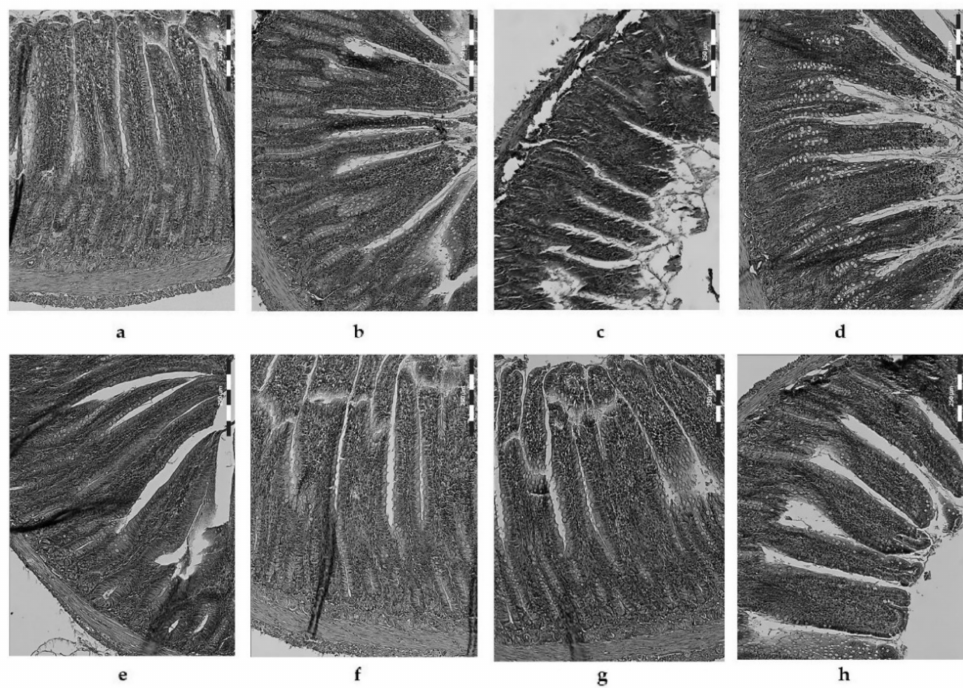
Figure 3. Histological examination of the rats’ ileum fed with control (C— a ), atherogenic diet (CH— b ) and CH diet supplemented with freeze-dried fresh (CHGF— c ) and thermally processed garlic: 90 s blanched (CHG90s— d ), fresh and microwaved (CHGF micro— e ), 90 s blanched and microwaved (CHG90s micro— f ), 10 min pan fried and microwaved (CHG10P micro— g ), and 10 min boiled in water and microwaved garlic (CHG10 micro— h ). Light microscope ( ×